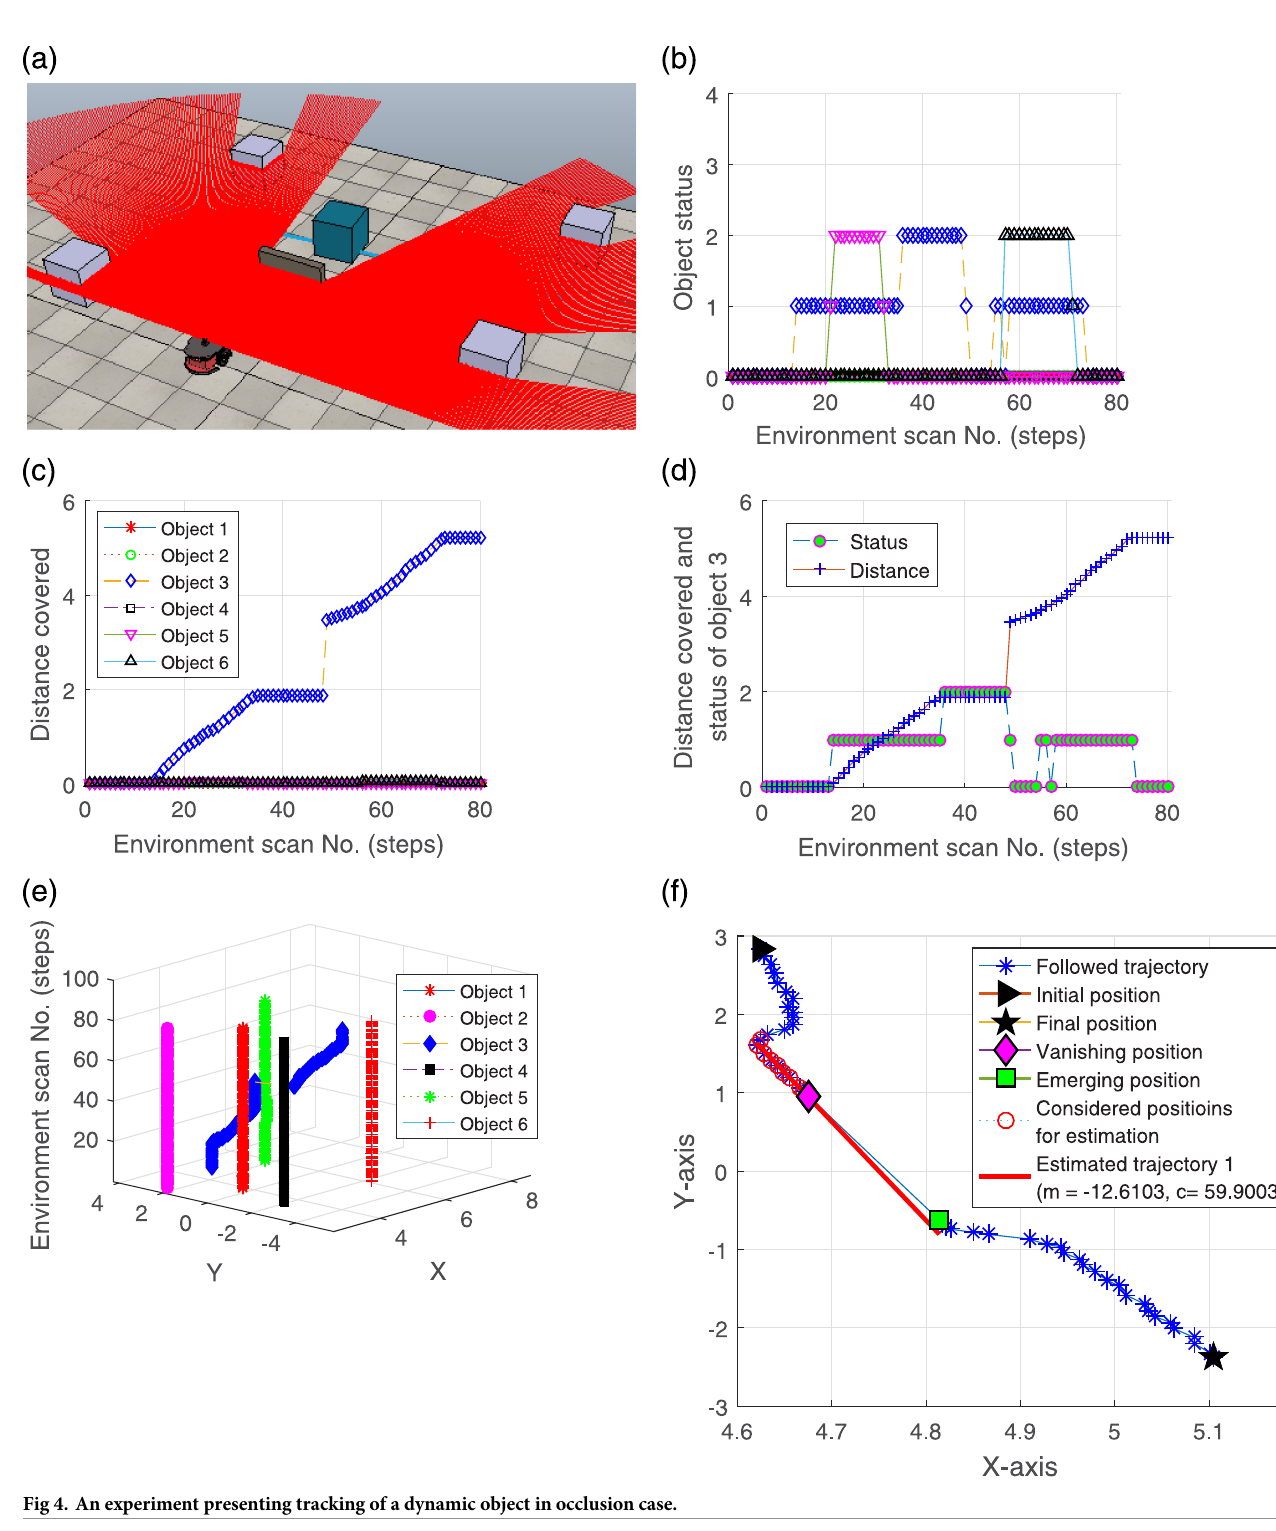
Fig 4. An experiment presenting tracking of a dynamic object in occlusion case.